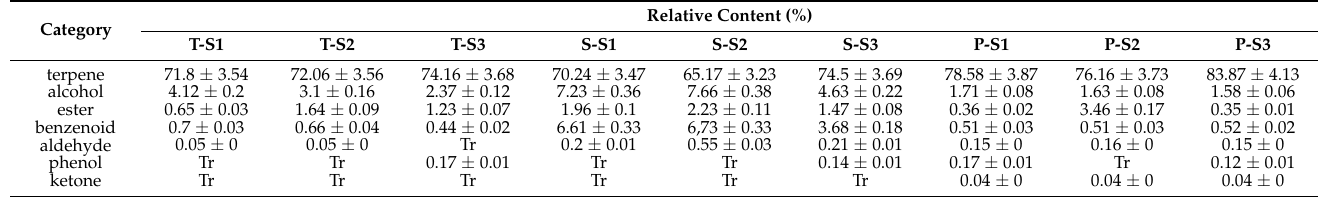
Table 1. Relative content of flower scent compounds of M. crassipes by chemical category. (T: tepals; S: stamens; P: pistil; S1: bud stage; S2: initial flowering stage; S3: full flowering stage; values are mean ± SD of five replicates).